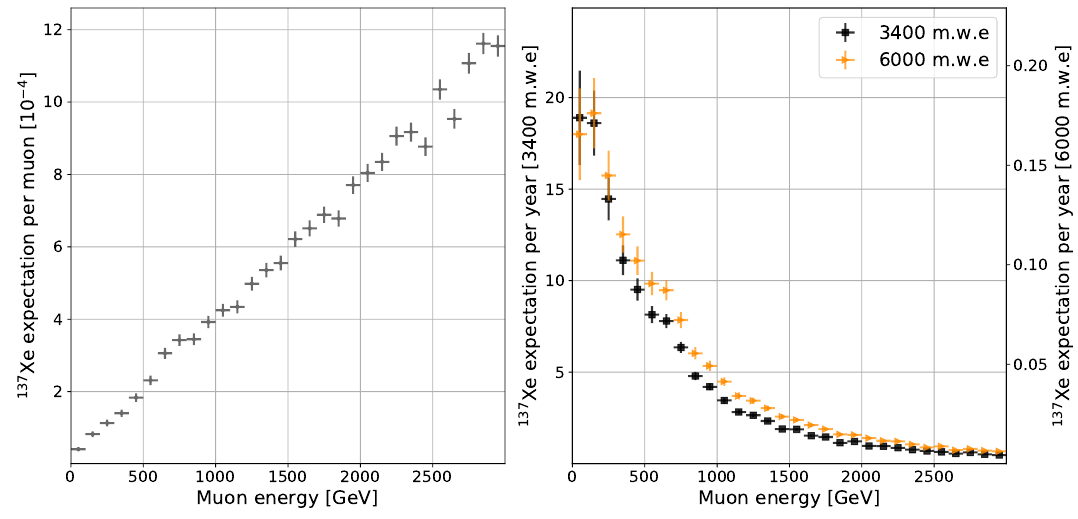
Figure 5 . Expected production rate of 137 Xe per interacting muon (left panel) and per year (right